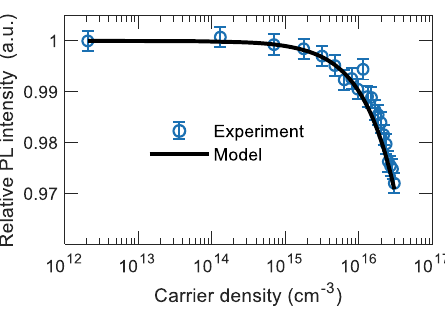
Fig. 2 PL quenching in mCP:4CzIPN HOD. The relative PL intensity from HOD under constant optical excitation as a function of carrier density. Fit to the quenching model is shown by the solid